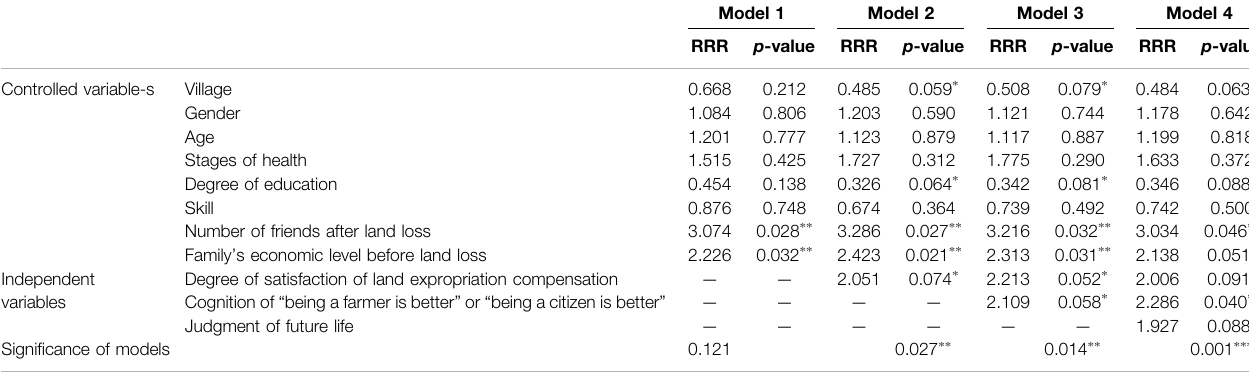
TABLE 5 | Logistic regression results of the impact of in situ urbanization on suburban youth entrepreneurship ( n = 228).